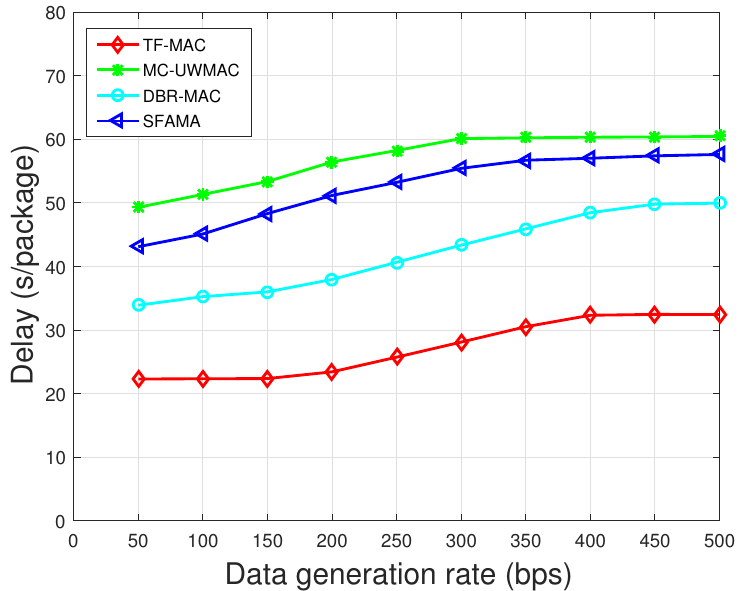
Figure 15. Comparison of end-to-end delay in the sparse network.